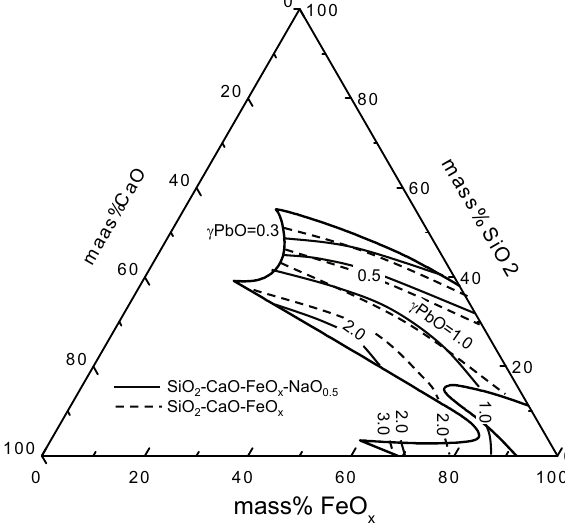
Figure 6. Contours of constant PbO activity coefficient in the slag in equilibrium with metallic iron at 1573 K.